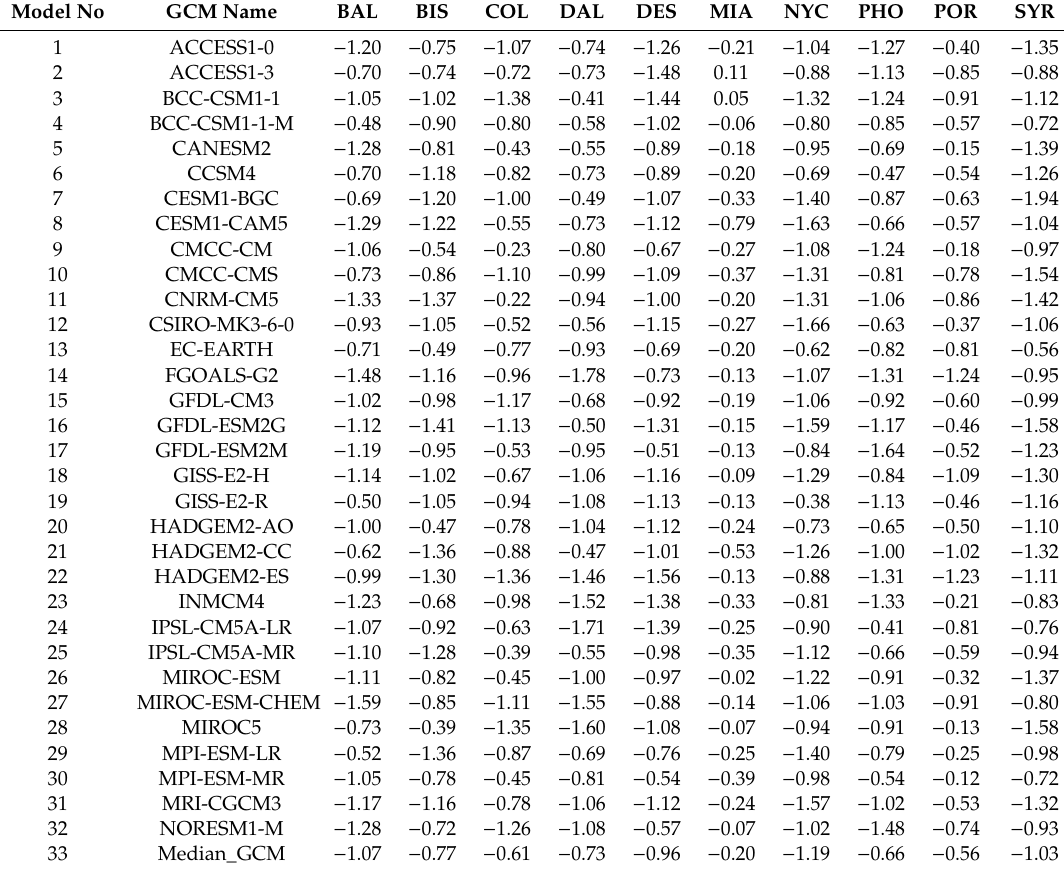
Table A6. NSE coe ffi cient of waves between observed and simulated data (1950–2005).